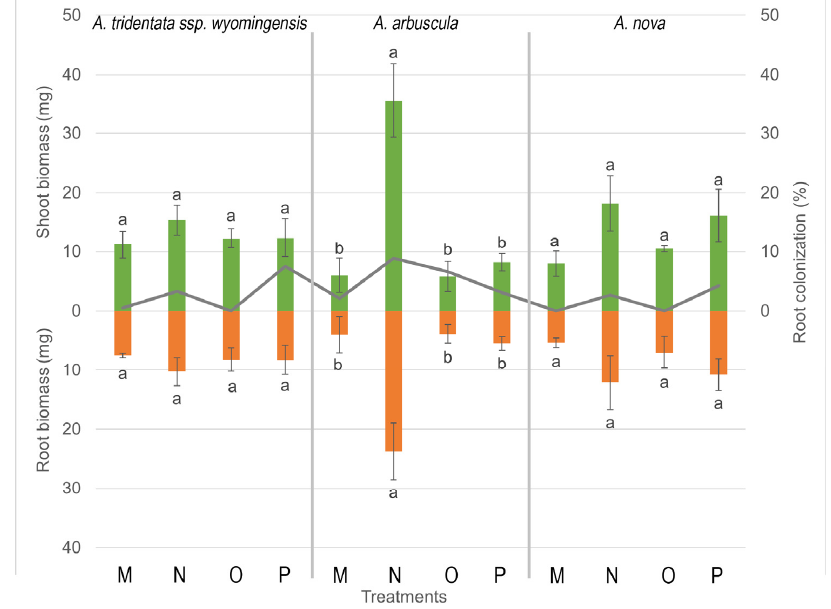
Figure 3. Shoot and root biomass (bars) and root colonization (lines) ±SE (error bars) of 3 species of Artemisia grown under different combinations of treatments (soil, moisture, and AMF inoculation) growing in competition with Taeniatherum caput-medusae for 21 weeks. Different letters above and below bars indicate significant differences among treatments (Tukey’s HSD). All treatments have commercial AMF inoculum, sham treatments not shown. Treatments: (M) high moisture, autoclaved soil; (N) high moisture, field soil; (O) low moisture, autoclaved soil; (P) low moisture, field soil.